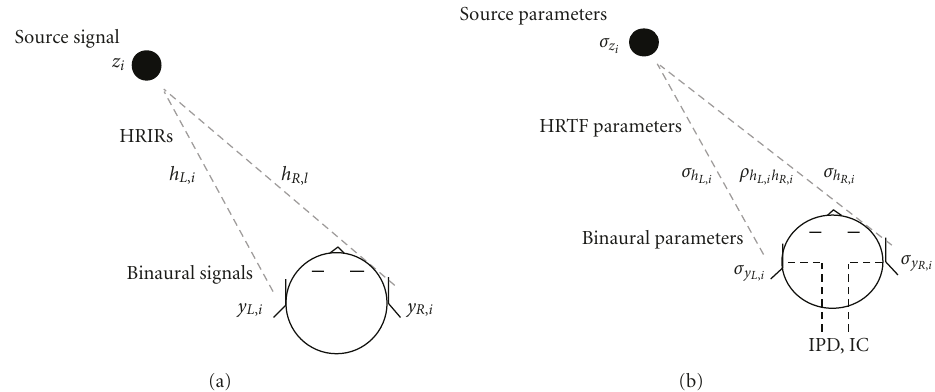
Figure 3: Synthesis of a virtual sound source by means of HRIR convolution (left panel) and by means of parametric representations (right